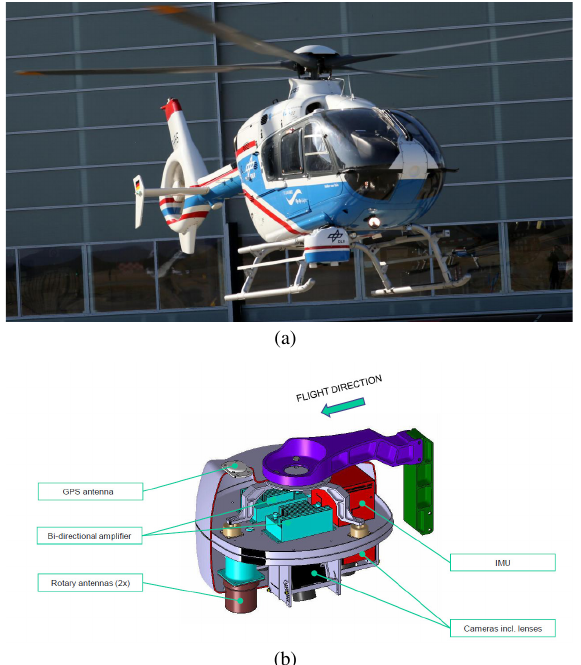
Figure 10. (a) helicopter EC 135 with 4K camera sensor unit. (b) system components of 4K sensor unit. which is not enough to decide unambiguously, whether a vehi- cle is parking or not.